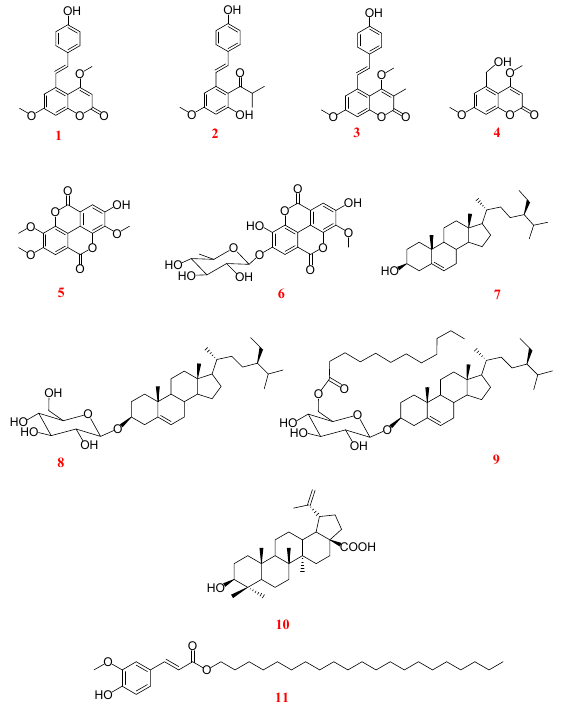
Figure 1. Structures of specialized metabolites 1–11 isolated from Monotes kerstingii [15]. Table 1. Minimum inhibitory concentration (MIC) of crude extracts, fractions, as well as natural and hemisynthetic pure compounds against Fo32931 and Fo4287.